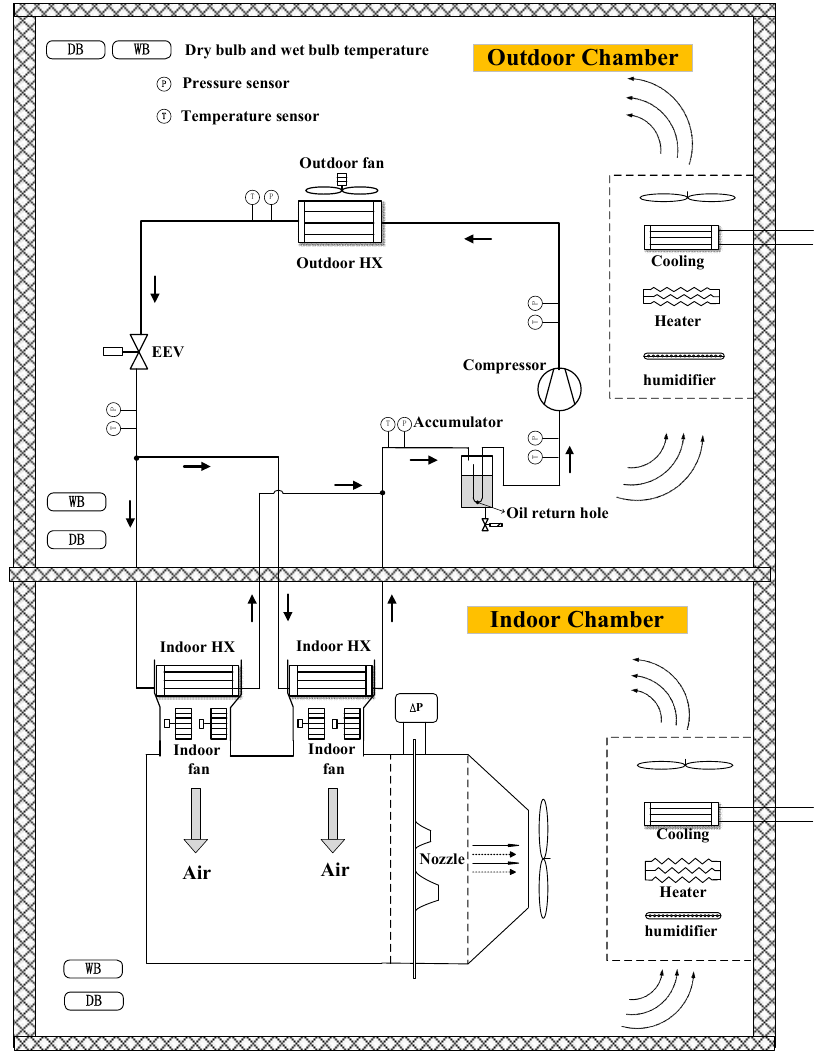
Figure 1. Schematic diagram of the transcritical CO 2 electric bus air conditioning system test rig.